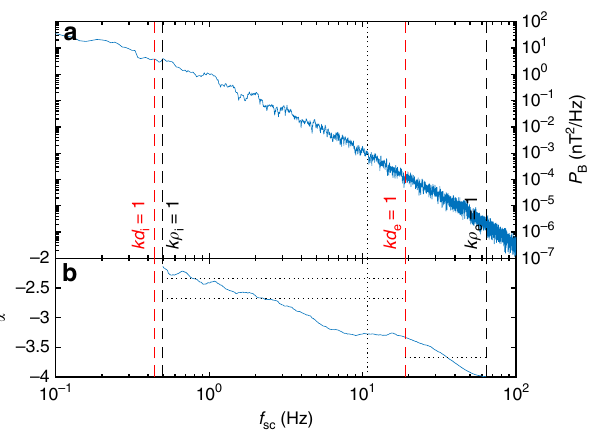
Fig. 5 Magnetic fi eld properties for the data interval. a Trace magnetic fi eld power spectrum P B and b local spectral index α ; horizontal dotted lines mark asymptotic cascade predictions − 7/3 12 and − 8/3 68 for kinetic Alfvén turbulence and − 11/3 for inertial kinetic Alfvén turbulence 60,69 , the vertical dotted line marks where the damping becomes